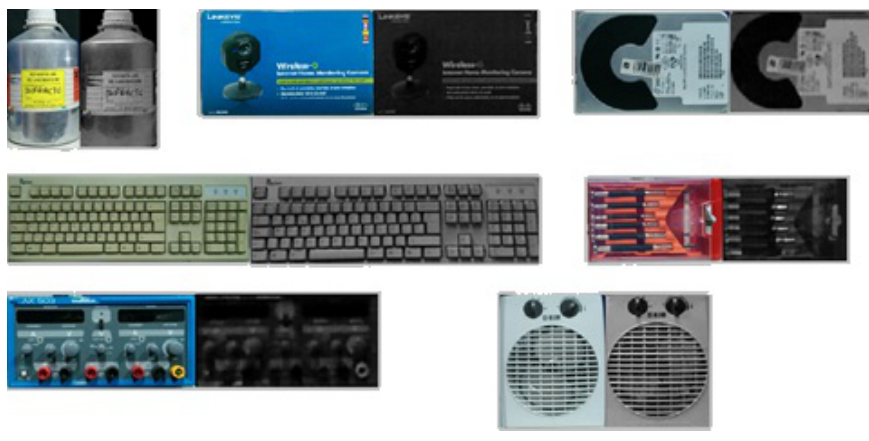
Figure 17. Experiment 2, objects selected.